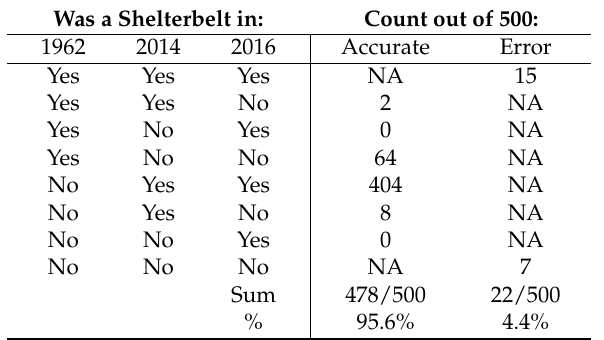
Table 1. Change detection accuracy assessment. This error matrix was used to assess the overall quality of detected change between the 1962, the 2014, and the 2016 digitized shelterbelt polygons. The assessment used 500 points placed randomly in areas of detected change to test if change occurred or not. An inaccurately detected change resulted from points that either had a shelterbelt in all three years 1962, 2014, and 2016, or not (Yes, Yes, Yes or No, No, No). All other possible combinations resulted in an accurately detected change. Was a Shelterbelt in: Count out of 500: